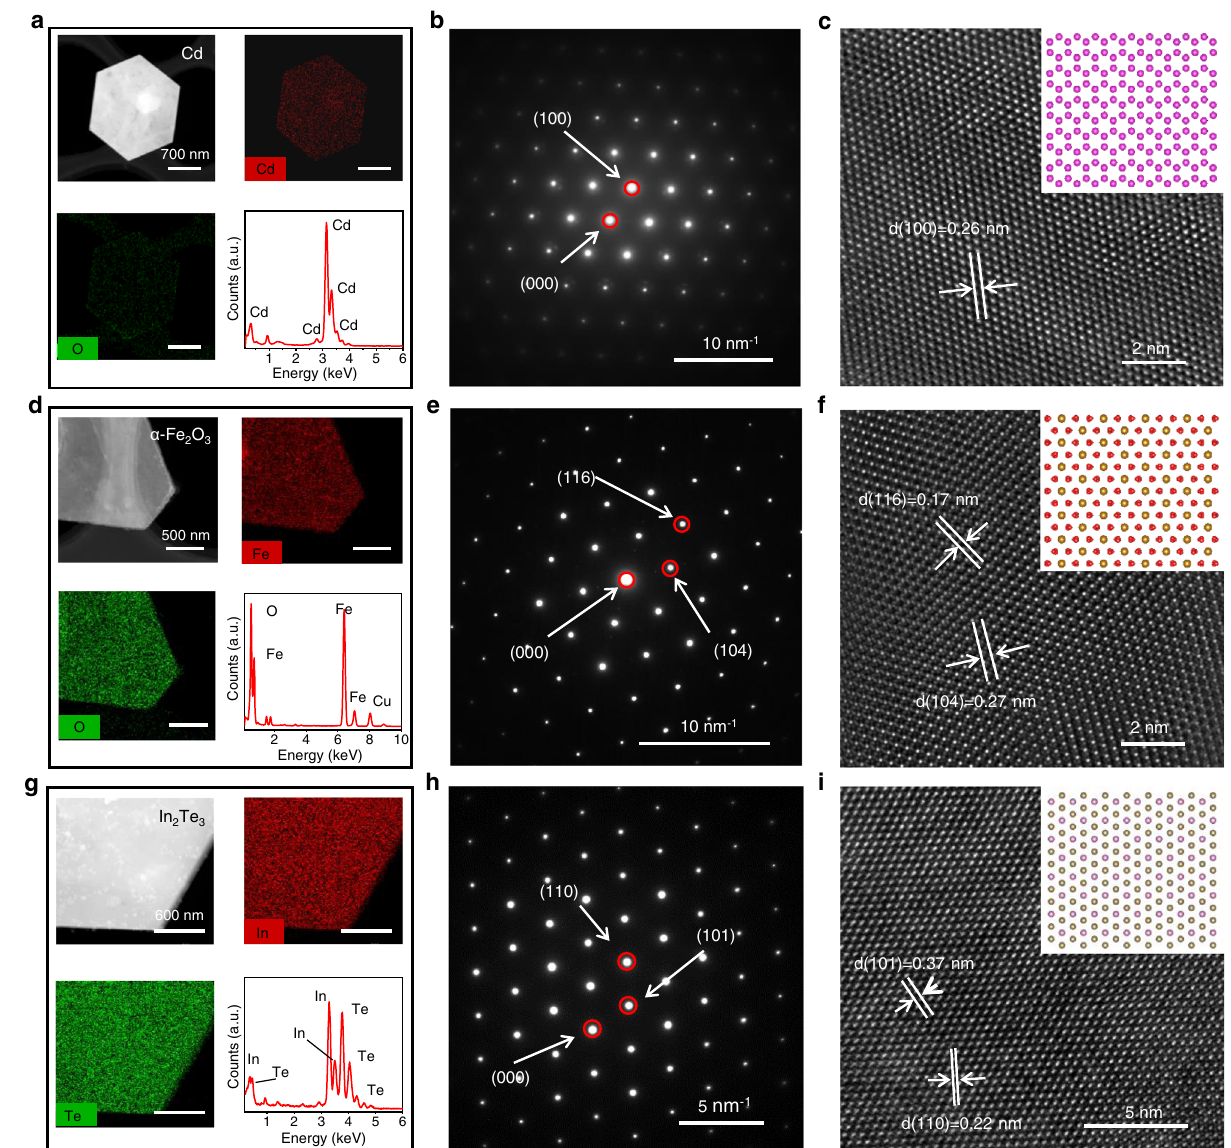
Fig. 3 | Crystal structure of 2D metals, oxides, and tellurides. a HAADF-TEM image, TEM-EDS mapping of Cd and O, and EDS of Cd nanosheets, respectively. b SAEDpatternofCdnanosheet. c HRTEMimageofCdnanosheet.Theinsetshows the corresponding atomic models. d – f Image of α -Fe 2 O 3 nanosheet